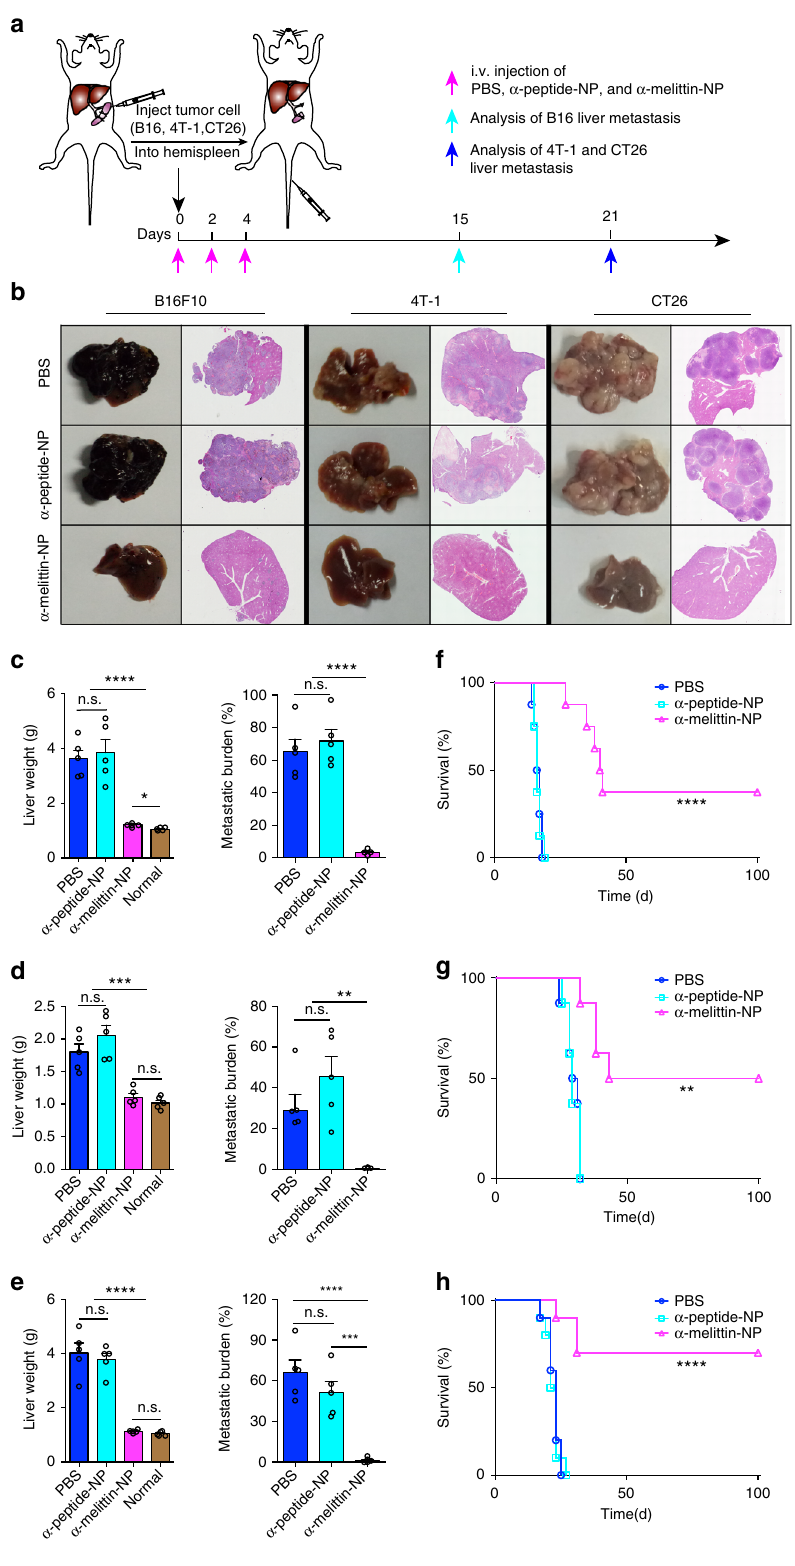
α -melittin-NP (Supplementary Fig. 11). Taken together, these fi ndings demonstrate that α -melittin-NPs not only stimulate the differentiation and maturation of NK cells, but also trigger T-cell- mediated systemic anti-tumor immune responses in the livers of tumor-bearing mice.